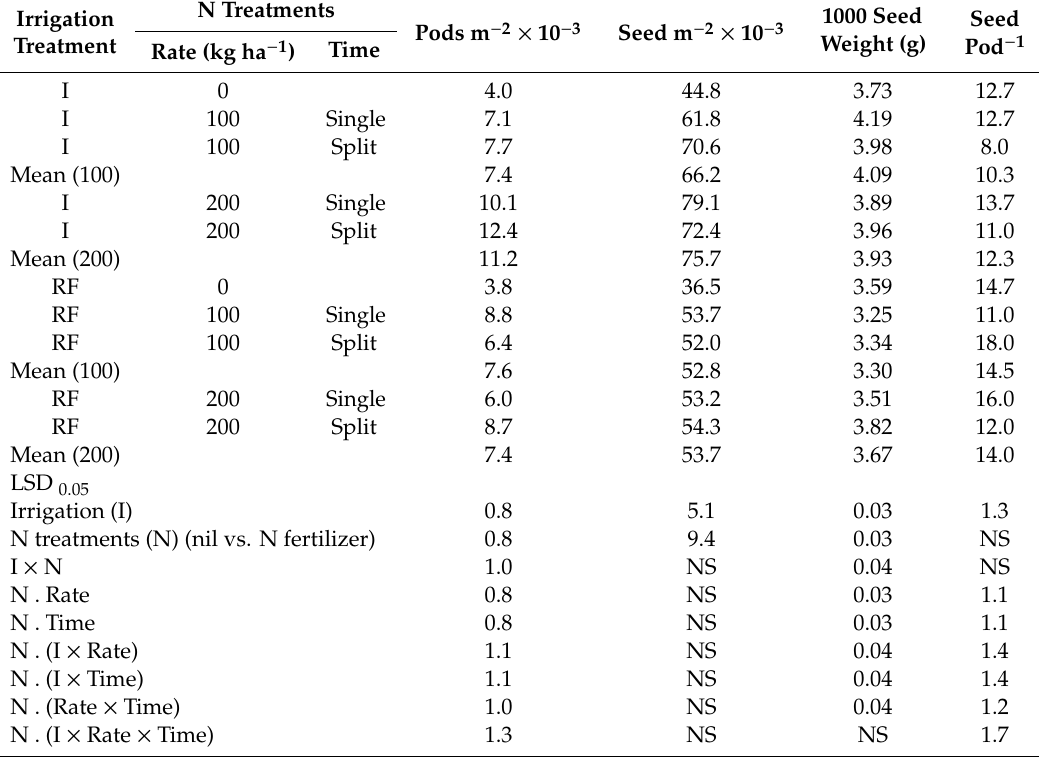
Table 4. E ff ect of di ff erent N application on yield components of canola under irrigated and rainfed conditions at Roseworthy